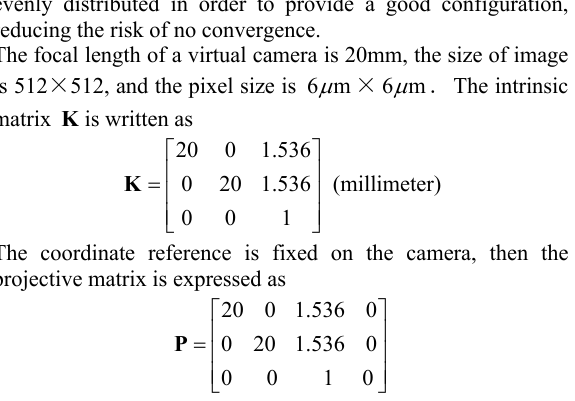
have good location performances. platform. Figure 2 demonstrates the appearance of target location program. The left window shows the aerial image, and the right window shows a digital map integrated with DEM data. The pixel marked by a red cross is the target in the aerial image, and its corresponding point in the map is calculated, marked by a green cross. So the geographical position is naturally obtained, displayed on the panel.